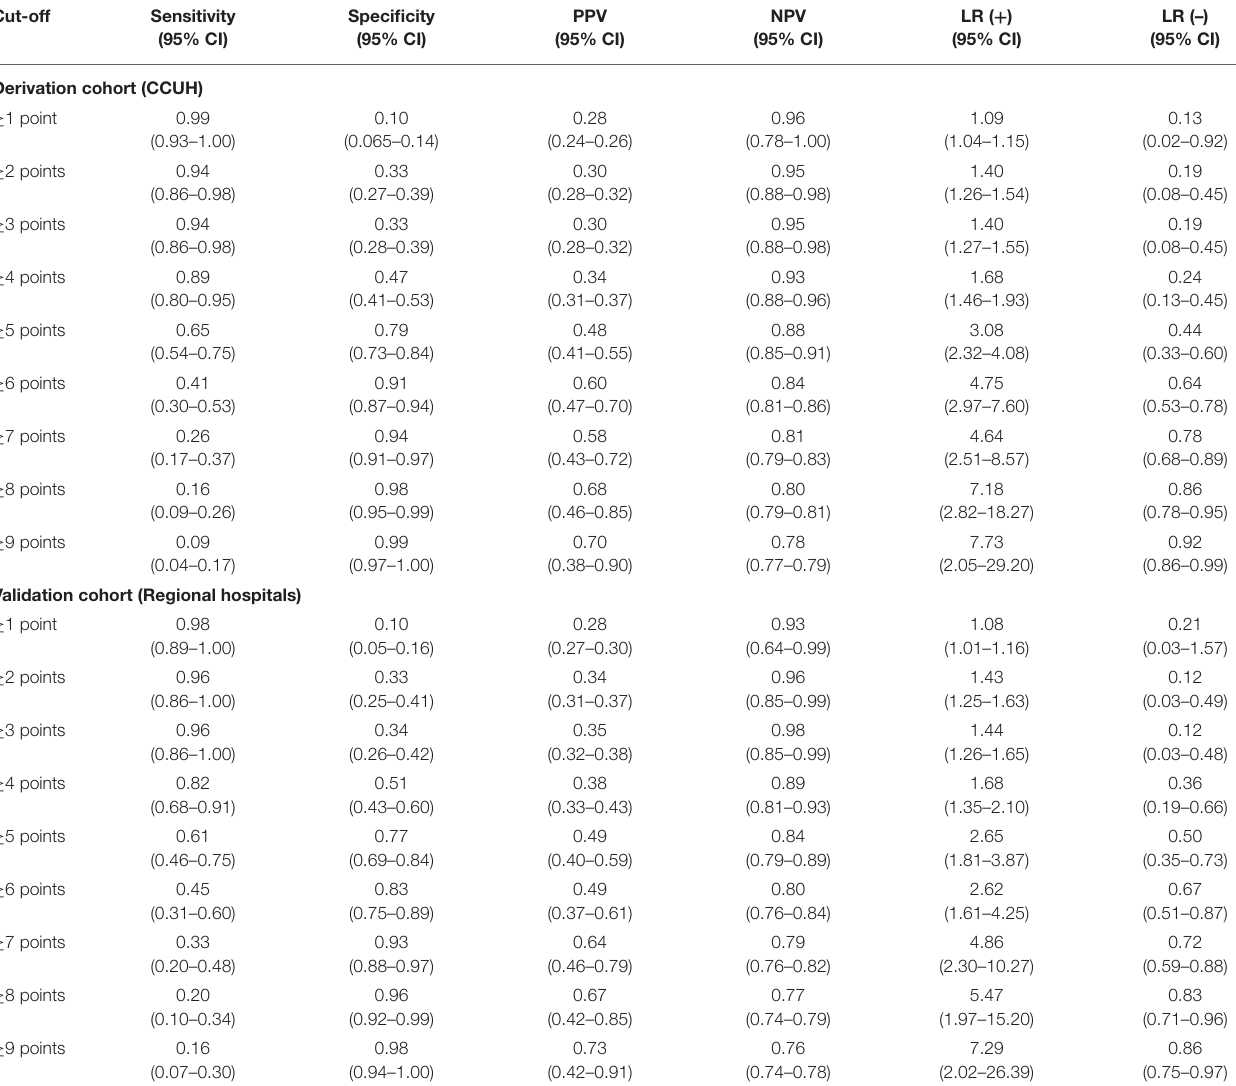
TABLE 9 | Diagnostic performance of scoring system based on CPM 2 at different cut-off score values in derivation and validation cohorts.